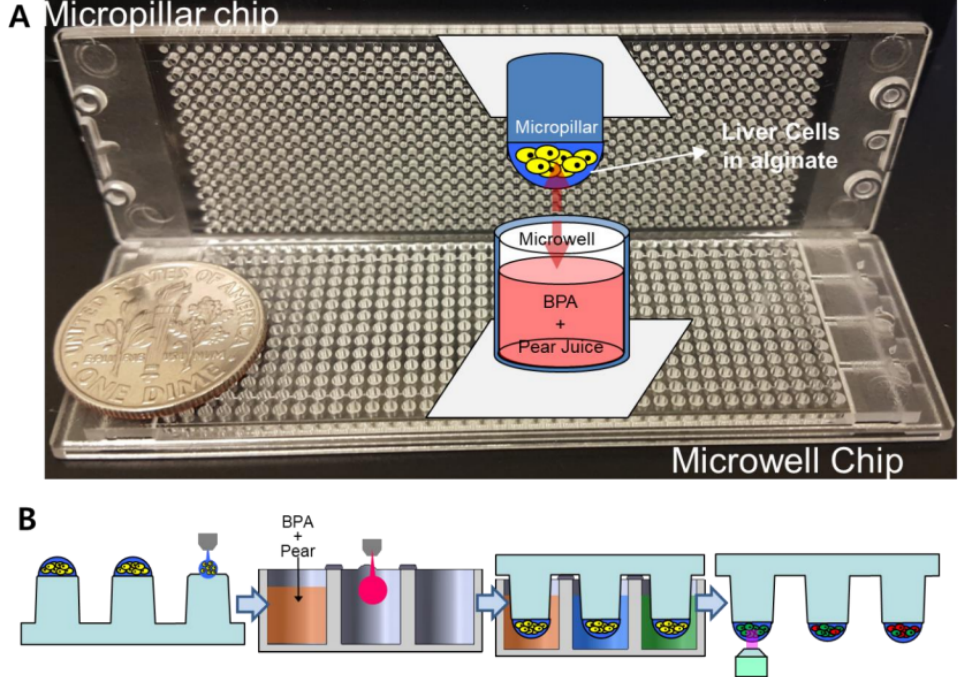
Figure 1. Assessment of detoxification mechanisms of Korean pear extract or arbutin on bisphenol A (BPA) with the micropillar / microwell chip platform: ( A ) Picture of injection-molded micropillar and microwell chips. ( B ) Schematic of experimental procedures for high-throughput screening of pear extracts or arbutin with BPA.